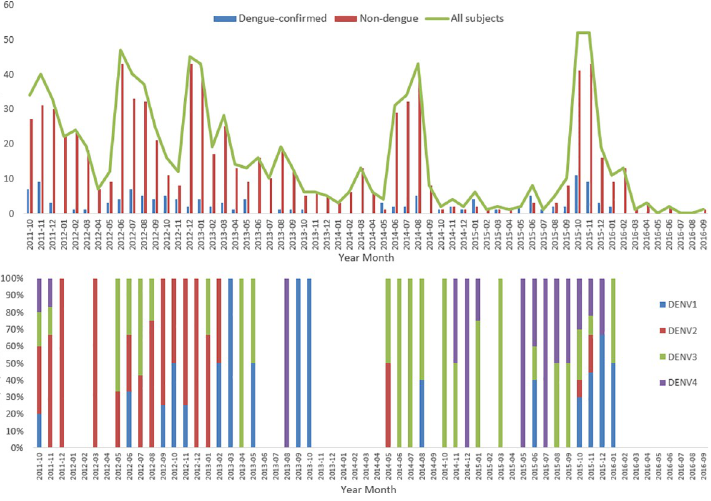
Fig 4. Monthly distribution of dengue and non-dengue cases among enrolled subjects during the study period. The figure shows monthly distribution of dengue-confirmed and non-dengue cases among the enrolled patients.